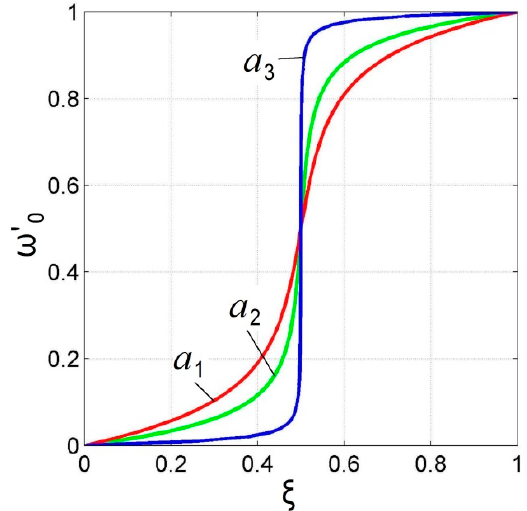
ω ′ , on the position of , on the position of 0 0